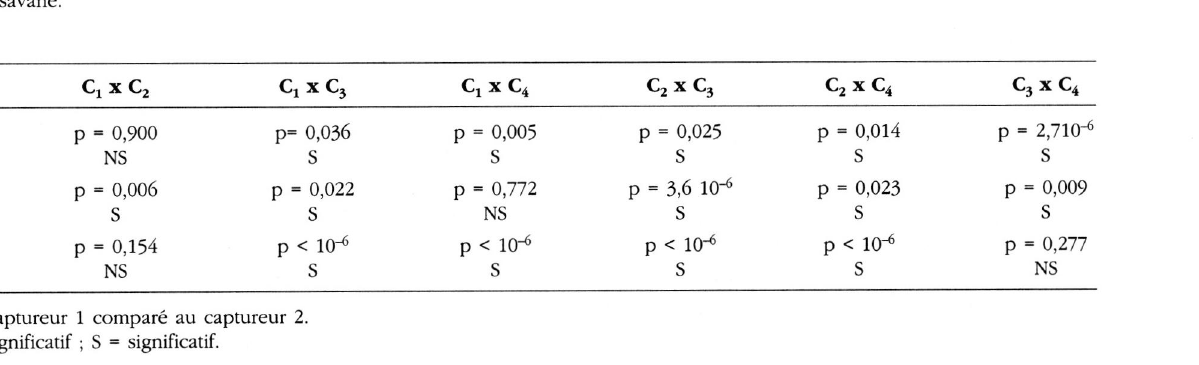
Tableau I. - Variabilité de l'efficacité des formulations Cotions, crèmes) à base d'huiles de coco, de palmiste et de gobi selon le captureur en zone de savane.